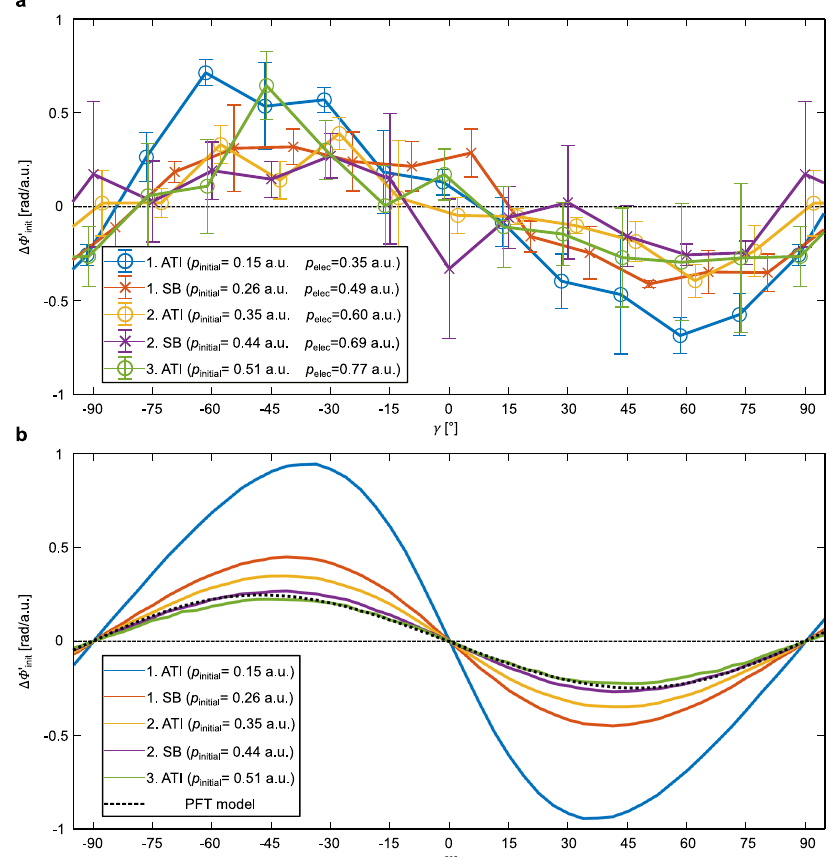
at the tunnel init at init